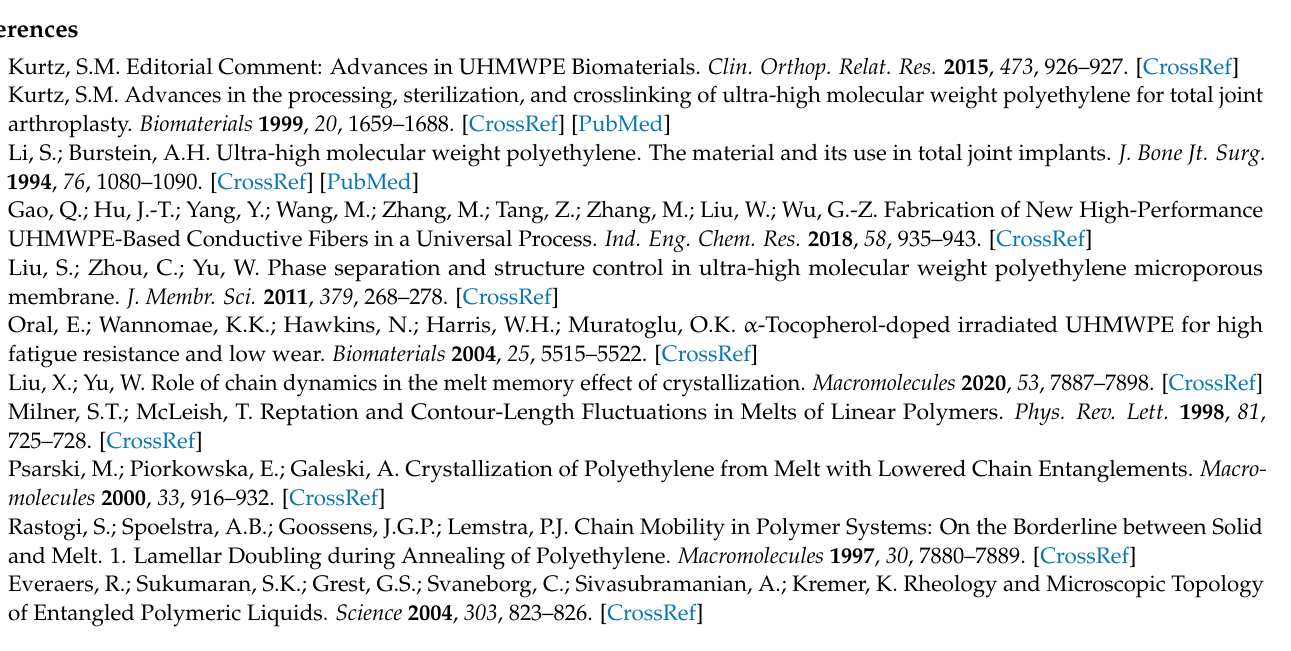
(e) represent fitting curves of I nDQ ; Figure S4: Fraction of the network-like protons as a function of temperature obtained by fitting based on Equation S3; Figure S5: Comparison of nDQ buildup curves from all of the samples at (a,b): 120 ◦ C and (c,d): 190 ◦ C. The solid lines in (a) and (c) represent fitting curves of I nDQ ; Table S1: PE used in experiments and their corresponding characteristics, including weight-average molar mass ( M w ), polydispersity (PDI), viscosity-average molar mass ( M η ) and [ η ]c; Table S2: The melting point ( T m ) and the crystallinity ( X c ) obtained by DSC plots. References [56–60] are cited in the Supplementary